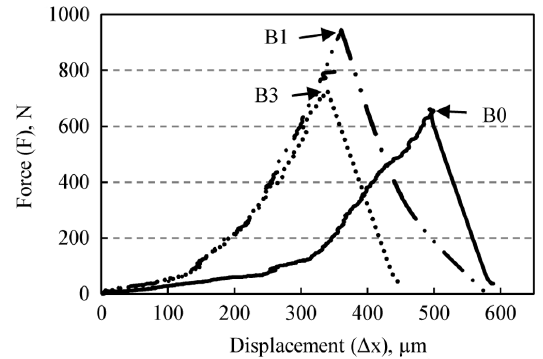
Fig. 6. Experimentally obtained force and strain curves under